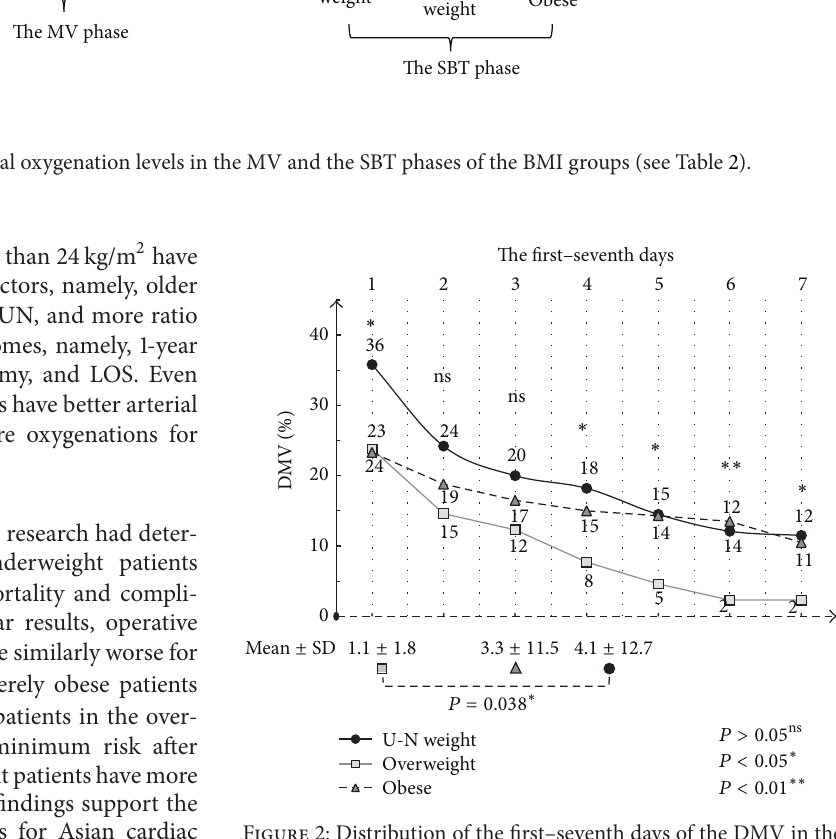
Figure 2: Distribution of the first–seventh days of the DMV in